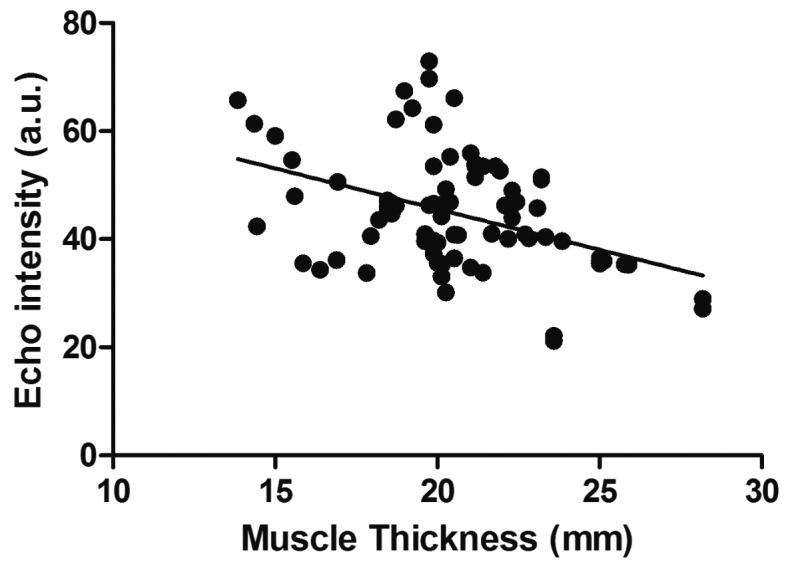
Relationship between muscle thickness and echo intensity in women (r=0.416, p<.0001).